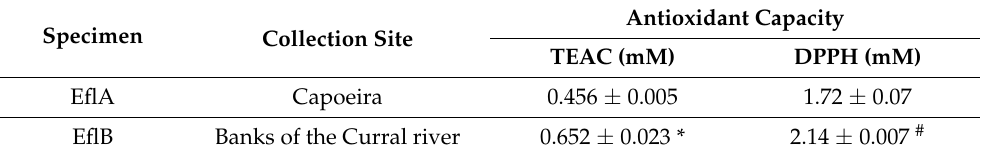
Table 2. Antioxidant capacity of essential oils from leaves of Eugenia florida specimens.